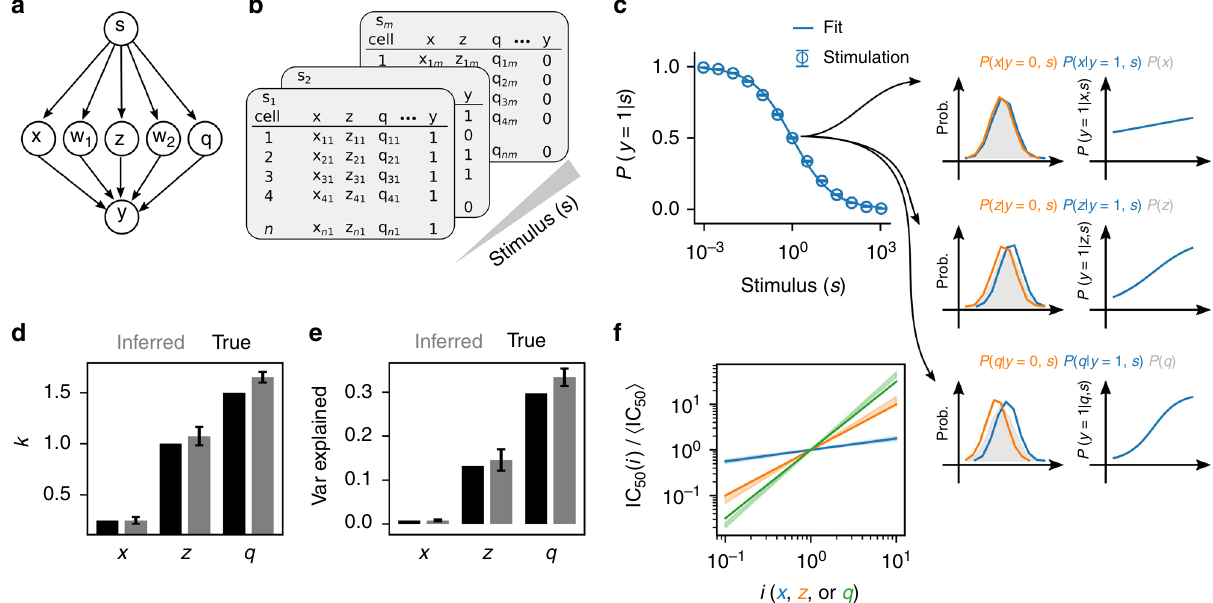
Fig. 3 Decomposing sources of cell-to-cell variability. a Schema for a simple cellular response, y ∈ {0, 1}, to the activation of pathway components w 1 , w 2 , x , z, and q representing the natural logarithm of abundances of each biological constituent subject to a dose of stimulus s . b Single-cell data were simulated to demonstrate the feasibility of CCV decomposition by sampling virtual cells (see Supplementary Note 3.3.4 for details). c The dose response of N = 10,000 simulated cells and n = 100 replicate experiments in which k x = 0.25, k w deviation about the mean. The probability density of the components given the cell state being live or dead from a single replicate experiment reveals how the logarithm of abundances of each biological entity correlates with cell state (left column). We further examine the dependence of cell survival on TRAIL by examining the probability of the cell state, y = 1, given the dose, the DEPICTIVE inferred parameters associated with a single replicate simulation, and the abundance of each biological component (right column). Quantitative assessment of the true (black) and the average DEPICTIVE inferred (gray) parameters k x , k z , k q ± one standard deviation ( d ) and the corresponding variance explained by each component ( e ). f The scaling of the IC 50 ( i ) with i = x , z , or q ± one standard